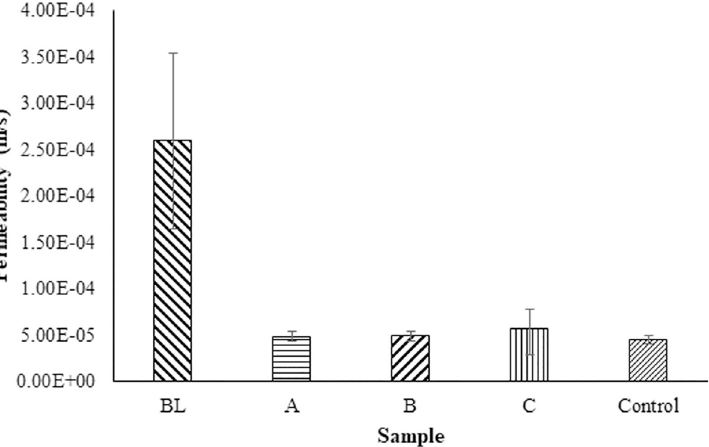
Fig 3. Measurements of soil permeability from the columns containing different biomineralising bacteria. A = Pseudomonas nitroreducens szh_asesj15; B = Bacillus sp. xjlu_herc15 ; C = Bacillus licheniformis adseedstjo15 and Control = Bacillus megaterium